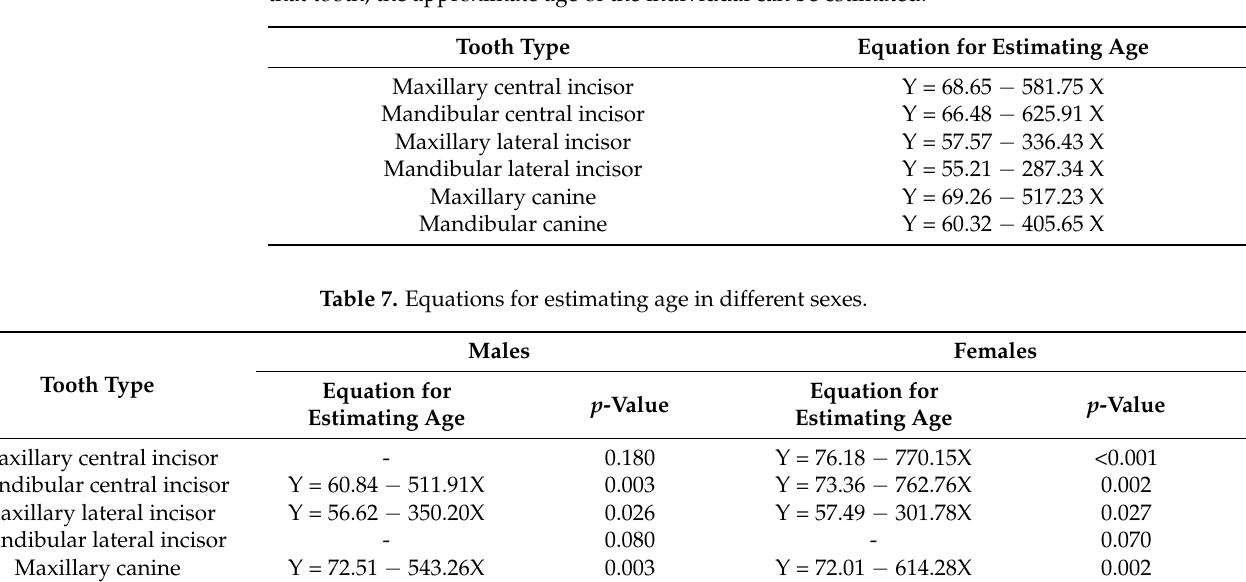
Table 6. Equations for estimating age. With the pulp–tooth volume ratio in the related equation of that tooth, the approximate age of the individual can be estimated.